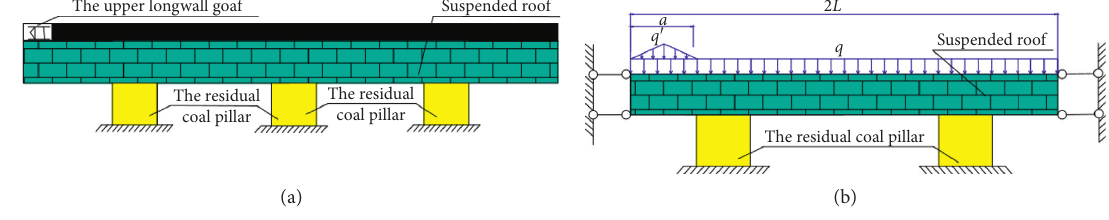
Figure 4: Diagrammatic figure and simplified mechanical model.